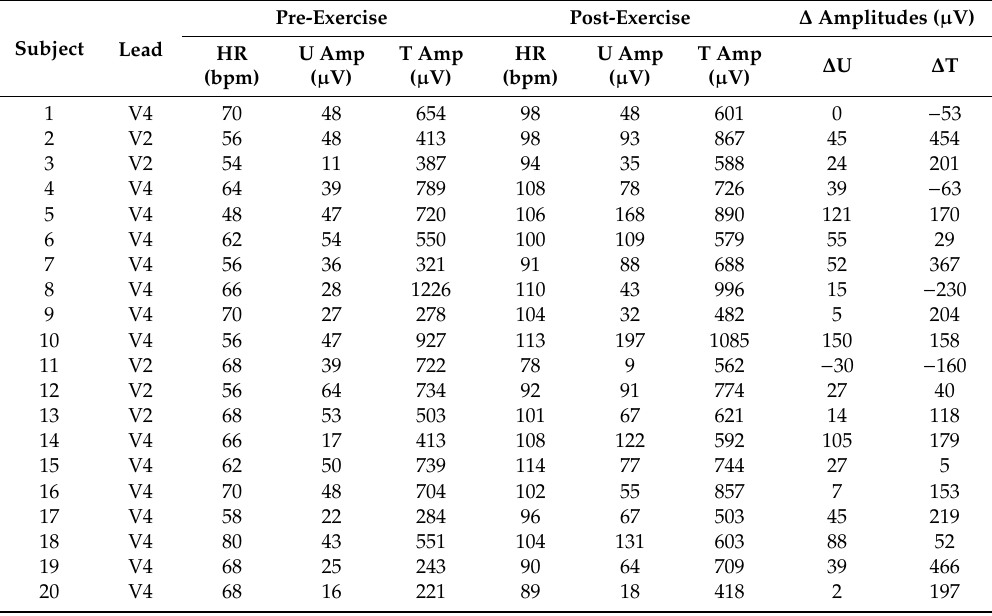
Table 1. Summary of 20 healthy subject measurements during pre- and post-exercise. HR = heart rate (bpm), T amp = T amplitude, and U amp = U amplitude; ∆ represents the change in amplitude between pre- and post-recordings in the respective